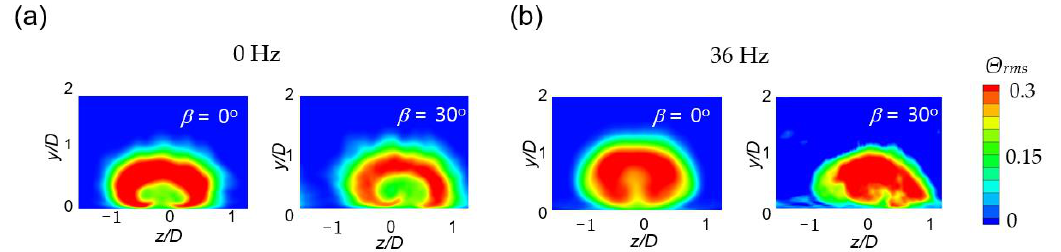
Figure 14. Reynolds stress contours [77]: ( a ) at z / D = 0, ( b ) at y / D = 0.5, and ( c ) at x / D = 2.5.